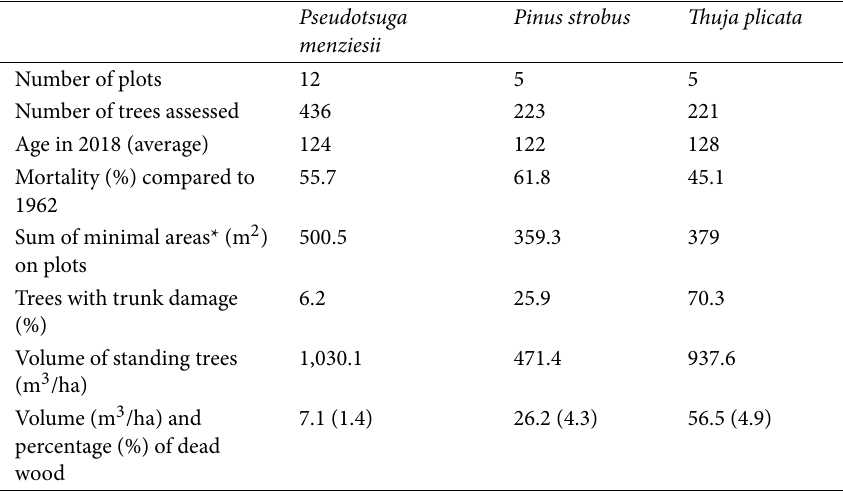
Table 3 General description of the studied plots containing introduced tree species.